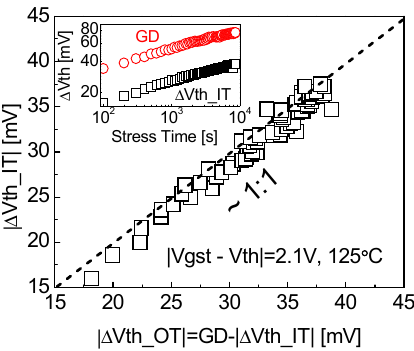
Figure 31. The one-to-one correlation between generated oxide charges and the charges from generated interface states [53].